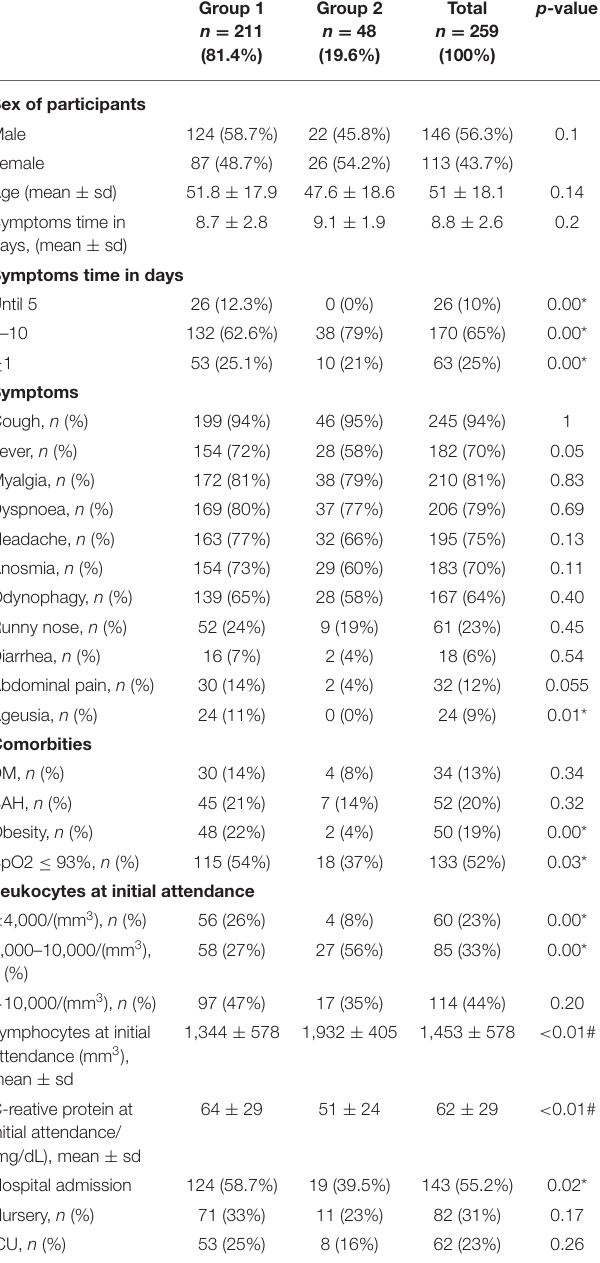
TABLE 3 | Main findings at Chest CT in symptomatic individuals by group (Belém, PA,